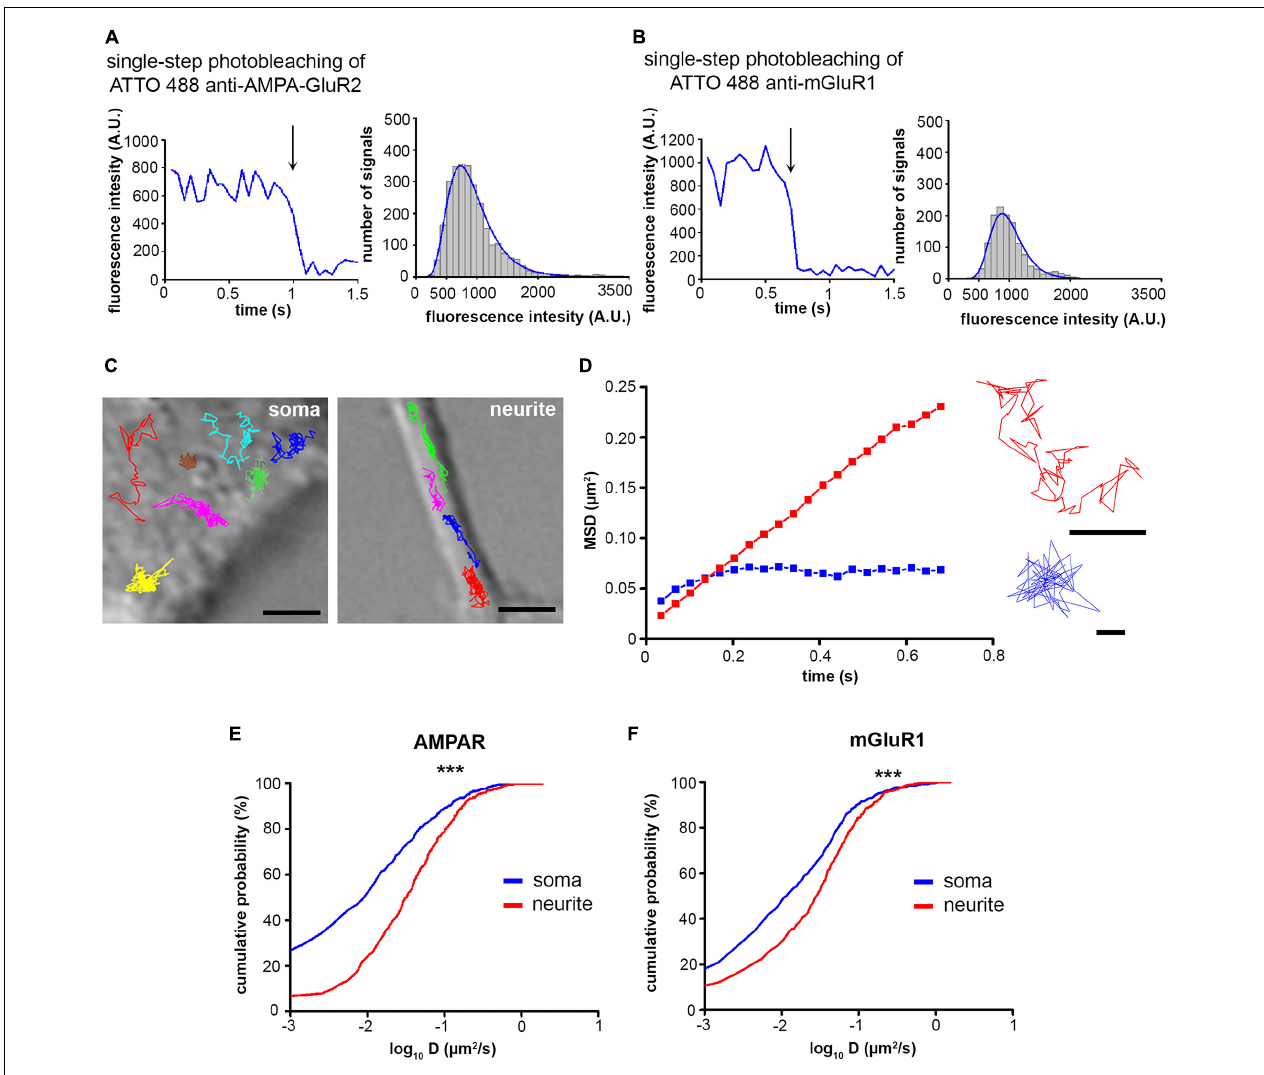
FIGURE 1 | Characterization of differentiated PC12 cells and validation of single-molecule labeling. (A,B) Left, Intensity profiles of a single ATTO 488-labeled GluR2-AMPAR (A) and mGluR1 (B) signal. The arrows indicate single-step photobleaching. Right, Histogram showing the intensity value of every spot found in a recording of ATTO 488-labeled GluR2-AMPAR (A) and mGluR1 (B) , superimposed with a single fitted lognormal curve (blue line). (C) Representative trajectories of AMPAR molecules on somas and neurites. Scale bar = 2 µ m. (D) The mean square displacement functions and trajectories represent AMPAR molecules with Brownian motion (red) and confined motion (blue). Scale bar = 0.1 µ m. (E,F) The cumulative probability functions of D values of AMPAR (E) and mGluR1 (F) on neurites and somas ( n = 510–676 trajectories). *** p <